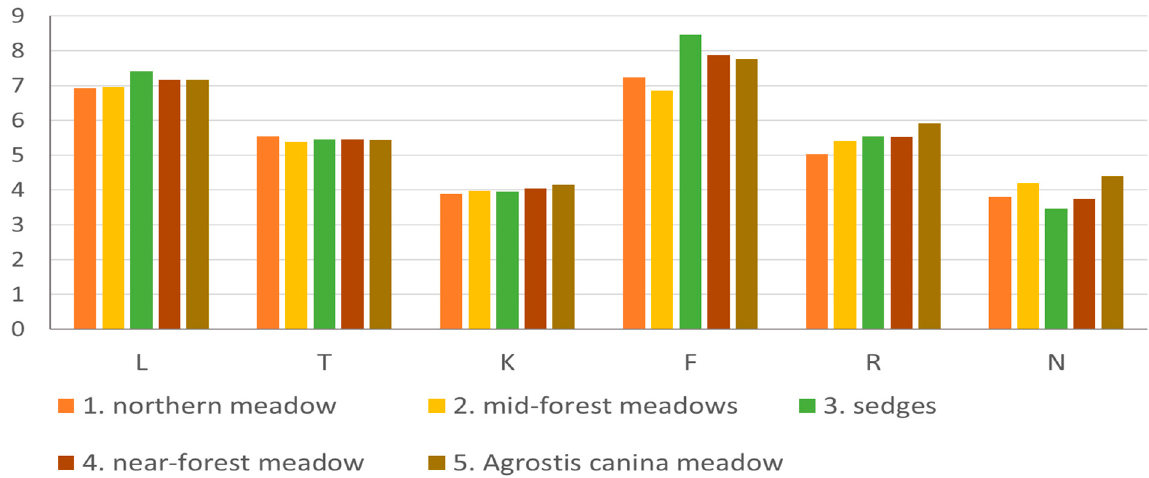
Figure 4. Mean values of ecological indicators of selected meadow communities (L—light conditions, T—temperatures, K—continentality, F—moisture, R—reaction, N—nitrogen content in soil).